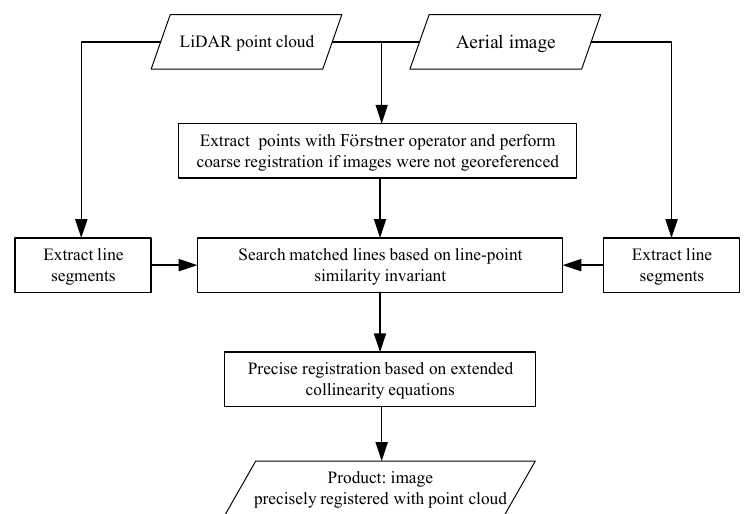
Figure 1. The flow chart of automatic registration of urban aerial images with LiDAR points based on the line-point similarity invariant and extended collinearity equations.